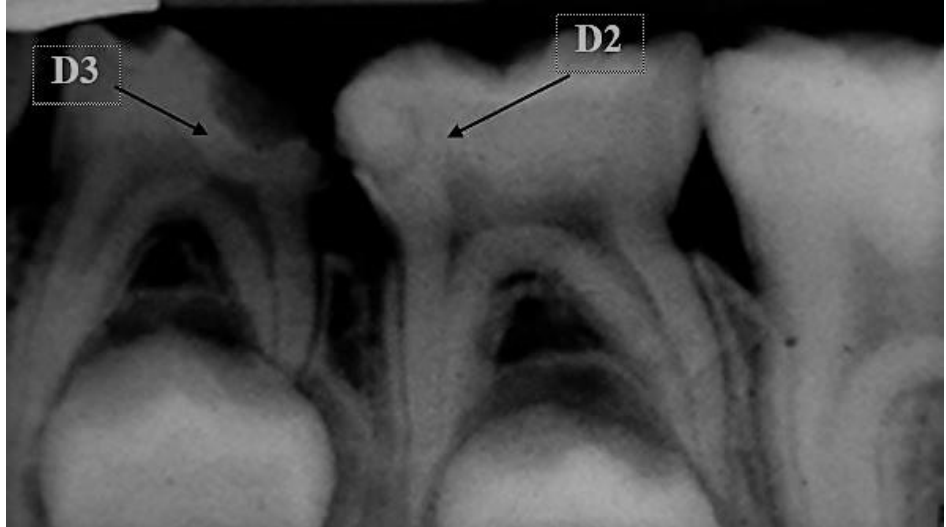
Figure 2. Preoperative periapical radiograph showing teeth 74 and 75. According to the American Dental Association Caries Classification System, tooth 74 showed disto-coronal radiolucency extending beyond the D3 level, i.e., into the pulp space and was treated with FSP. Tooth 75 shows mesio-coronal radiolucency extending beyond level D2, i.e., near the pulp horn and treated with IPT.